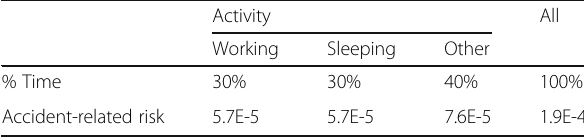
Table 1 Accident-related risks for railway crew members and MOW personnel distributed throughout the